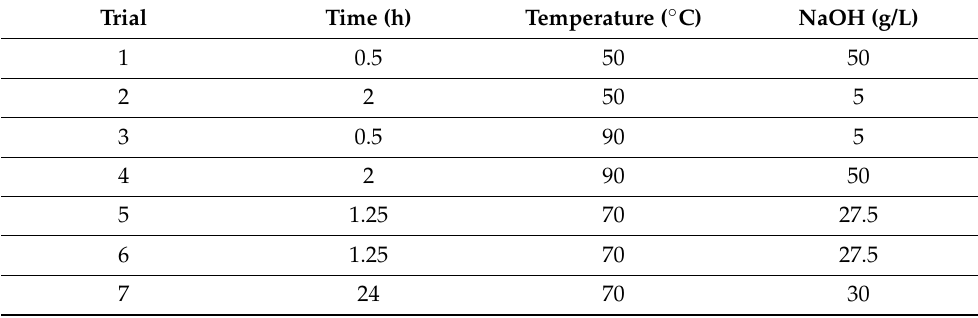
Table 7. Test conditions for caustic trials.